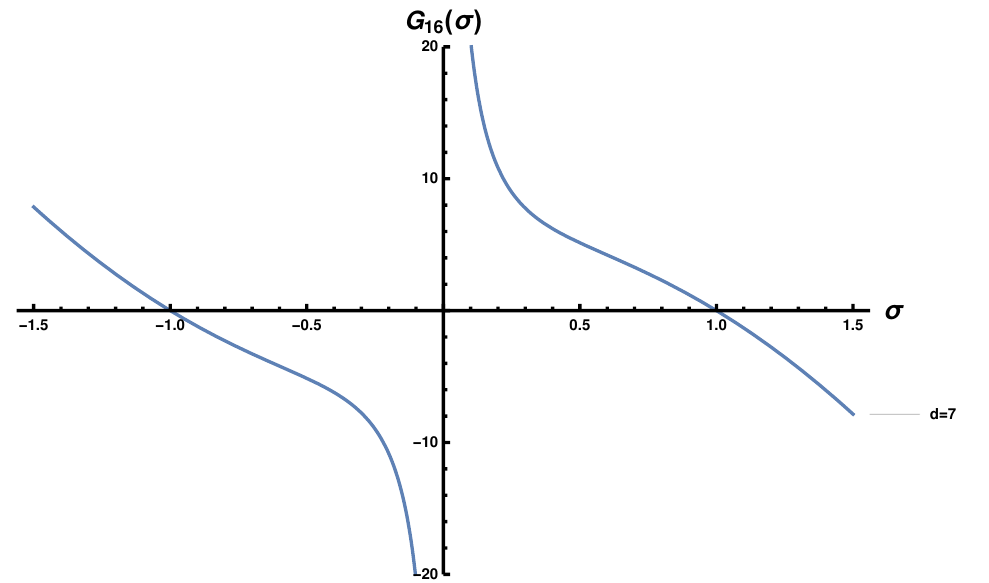
Figure 6 . The kernel G 16 ( (cid:27) ) for d = 7. At j (cid:27) j = 1 the kernel crosses over from repulsive to attractive